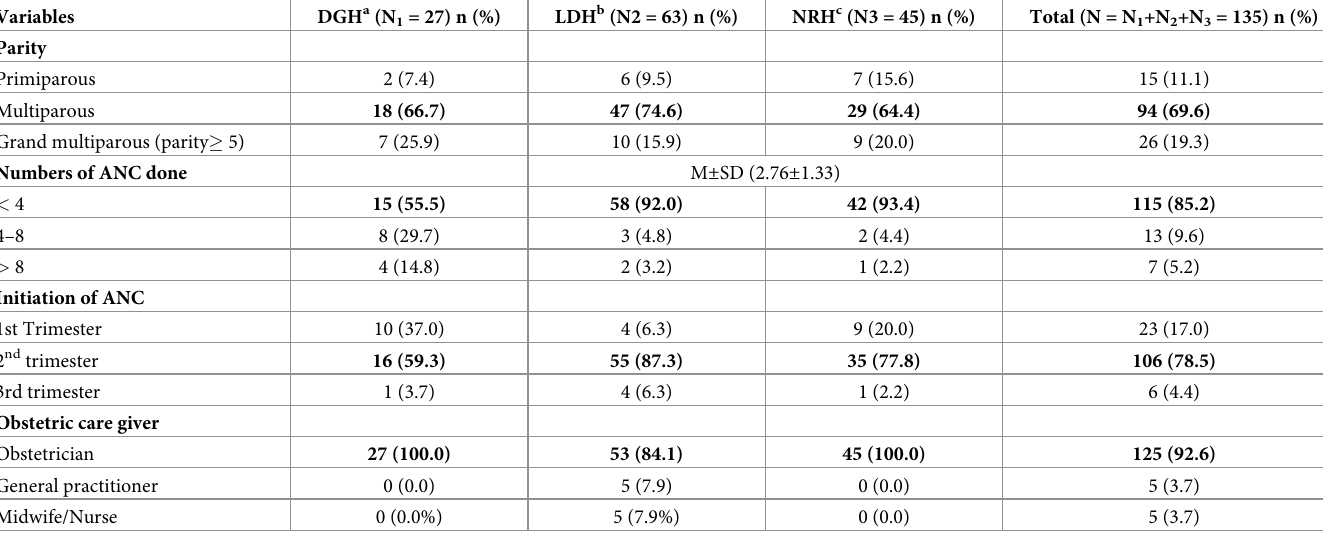
Table 2. Obstetrics information of study population (N =